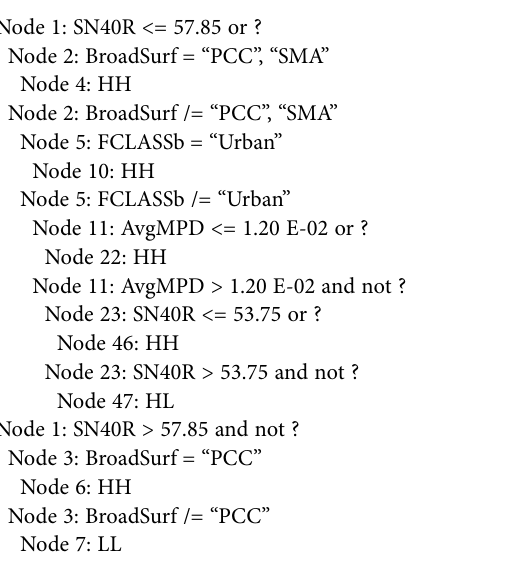
Fig. 6. GUIDE Classification Tree result of hotspots of weather-related crash rate in Wisconsin